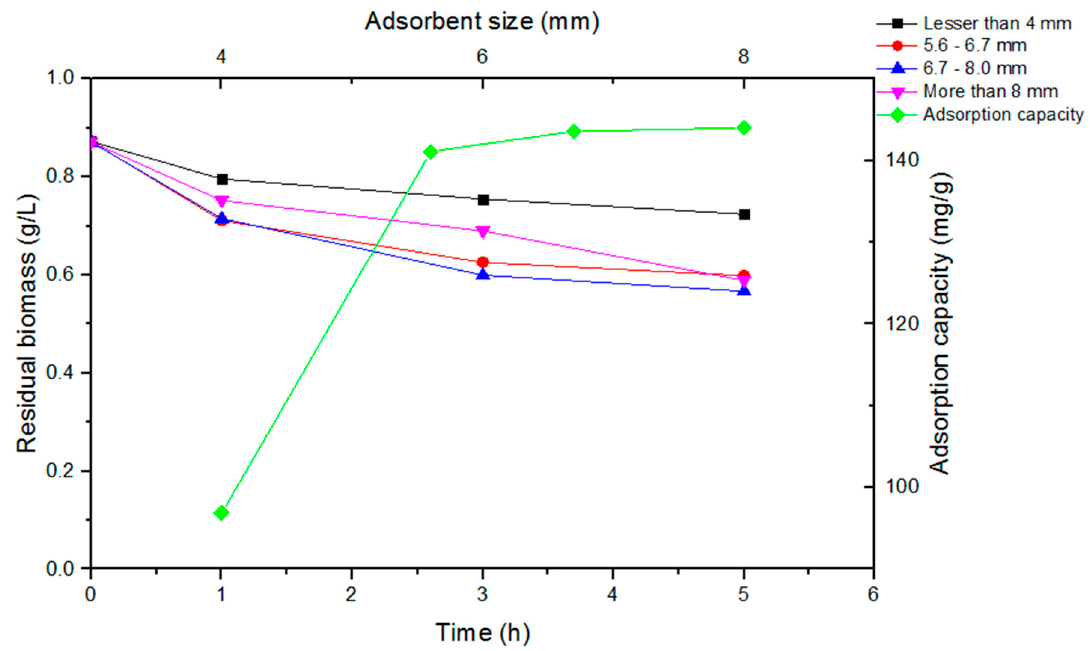
Figure 3. The time courses of residual biomass concentrations of microalgae adsorbed onto various sizes of acid-modified sugarcane-bagasse-based adsorbent and the consequent adsorption capacities from the use of each adsorbent size.